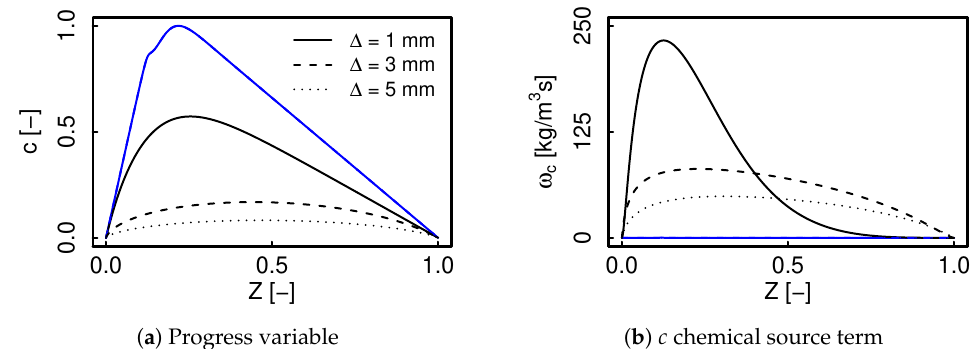
Figure 3. Flamelet transformation for two different strain rates and three filter sizes. Blue lines K = 0.03 s − 1 and black lines K = 482 s − 1 . The three blue lines superimpose so that only one profile can be